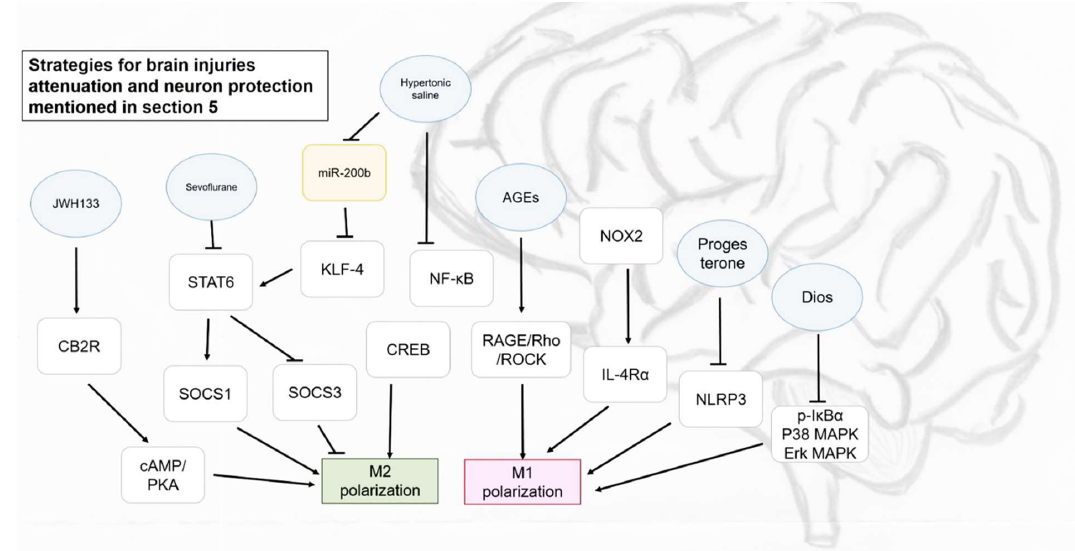
Figure 4. Some strategies proposed for brain injuries attenuation and neuron protection mentioned in Section 5. Blue circle, samples intervened; yellow block, microRNA intervened; white blocks, genes/proteins involved.